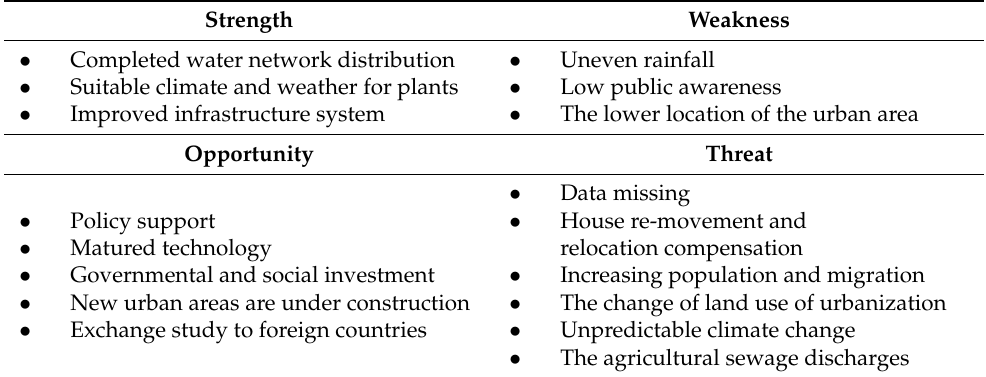
Table 3. SWOT analysis of the current condition in Kunming for Sponge City